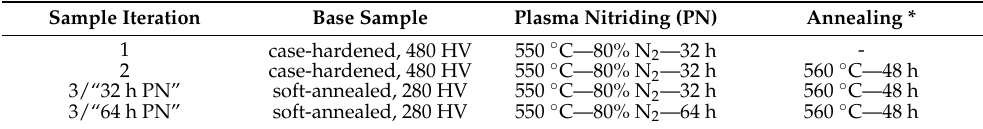
Table 2. Test parameters for the investigation of austenitisation behaviour.